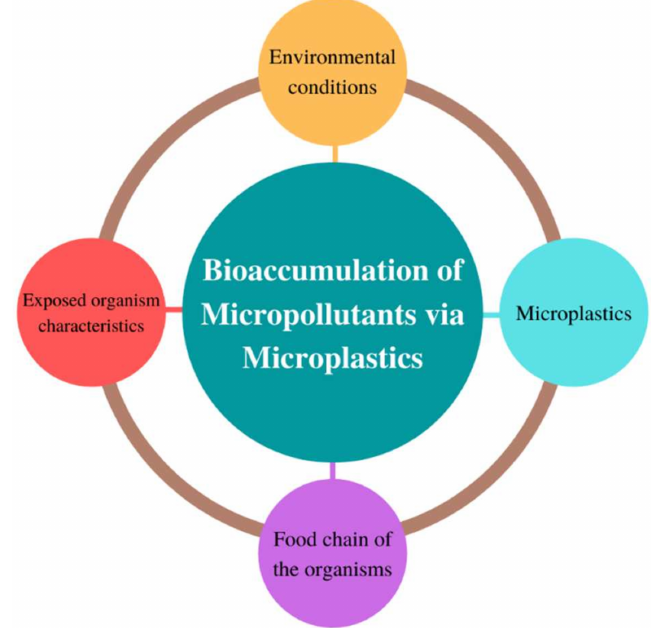
Figure 2. Factors influencing the bioaccumulation of micropollutants in an organism from exposure to microplastics as a